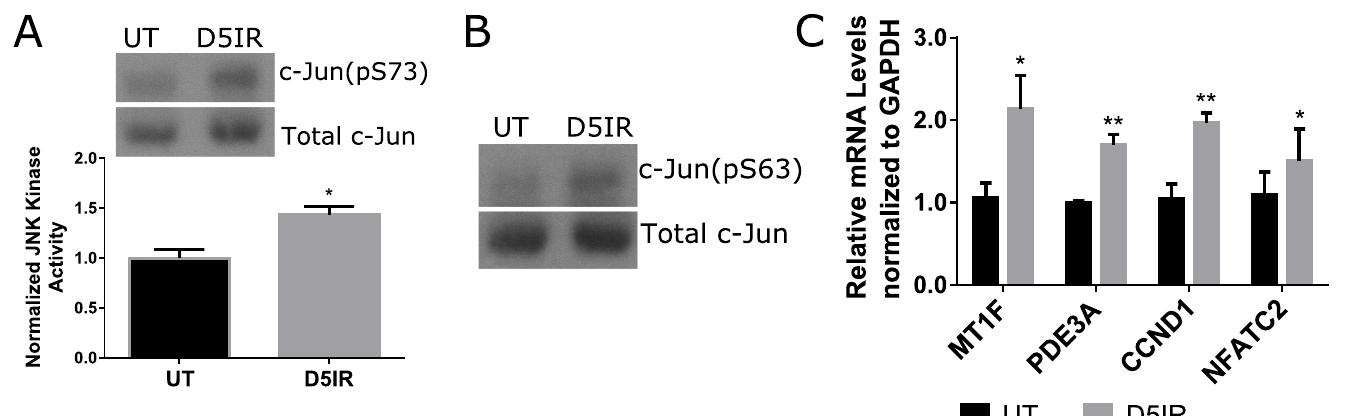
Fig 3. Radiation induces JNK signaling in vivo. FVB mice were either untreated (UT) or irradiated (IR) with 5Gy and dissected on day 5 following radiation treatment to evaluate JNK signaling. (A) Relative JNK kinase activity was measured by incubating immunoprecipitated JNK in the presence of ATP and a c-Jun substrate. The amount of phosphorylated c-Jun (S73) was detected via immunoblots. (B) Levels of phosphorylated c-Jun (S63) were determined following radiation treatment. Total c-Jun was probed as a loading control. (C) Relative mRNA levels of MT1F, PDE3A, NFATC2, and CCND1 were determined by RT-PCR and normalized to GAPDH. Results are presented from at least four mice per condition. Significant difference (p < 0.05) was determined by Student’s t-test. � (p < 0.05), �� (p <